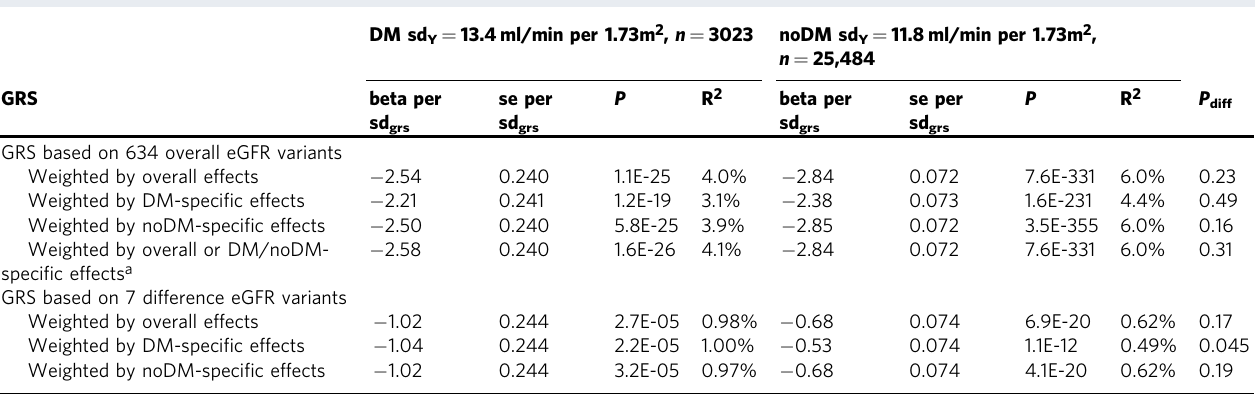
Table 3 Genetic risk score (GRS) association with eGFR and explained variance of eGFR separately for DM and noDM individuals.